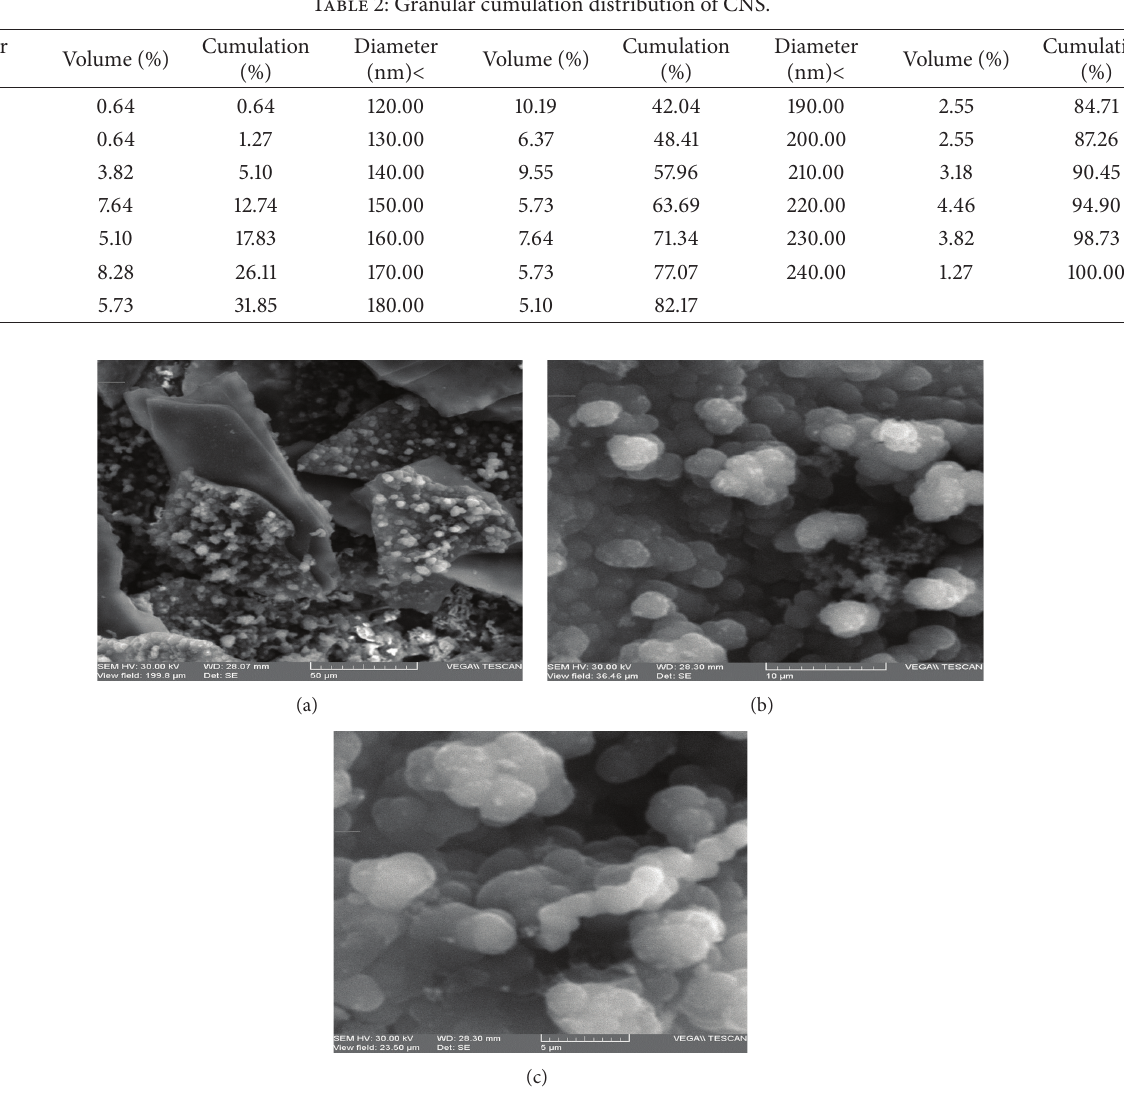
Figure 4: (a) Scanning electron Microscope (SEM) spectra of carbon nanospheres produced from Iraqi deoil asphalt directly after collection from the surface of CVD reactor. (b) SEM image of CNS. (c) SEM image of agglomerated